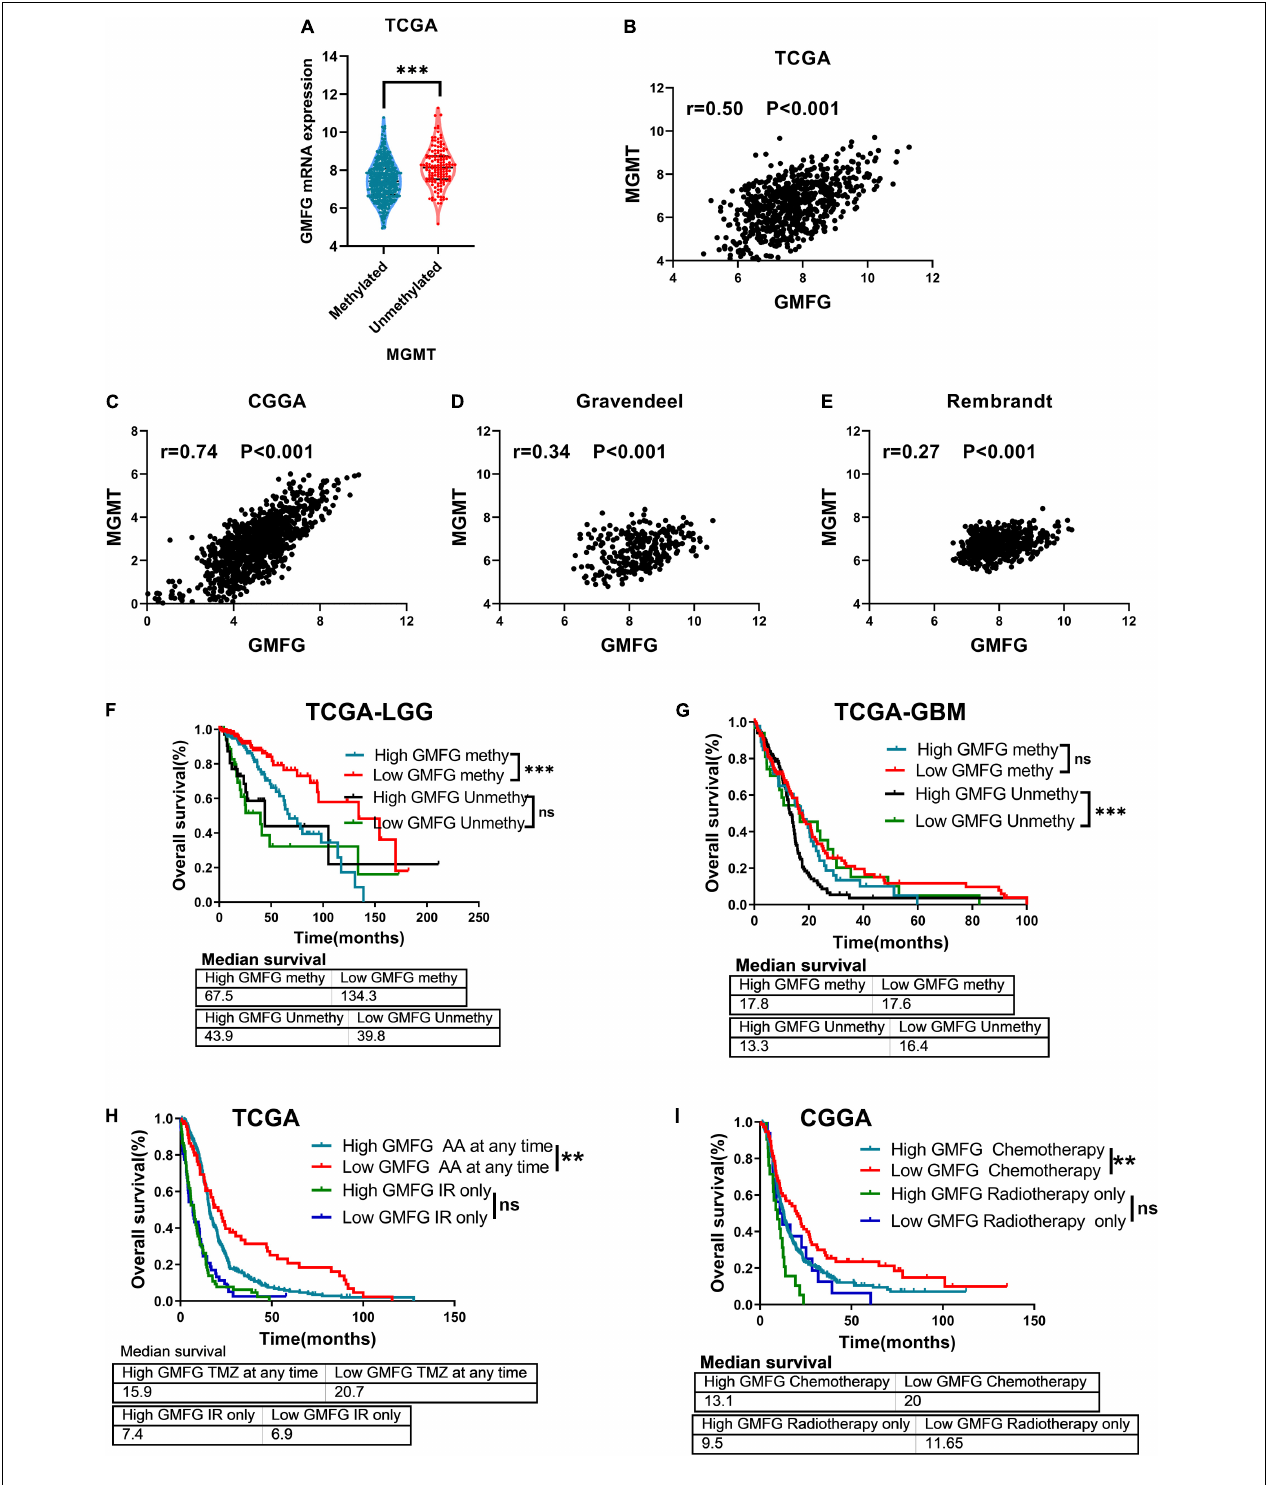
FIGURE 8 | Glia maturation factor- γ associated with TMZ response of gliomas. (A) Association between GMFG expression and MGMT promoter methylation status. ∗∗∗ P < 0.001. (B–E) Correlation between GMFG expression and MGMT expression in TCGA, CGGA, Gravendeel, and Rembrandt datasets based on Spearman correlation analysis. (F,G) Effect of GMFG on the prognosis of patients with LGG and GBM with different MGMT promoter methylation status. HR, hazard ratio. ∗∗∗ P < 0.001, ns, no significance. (H,I) Effect of GMFG on the prognosis of gliomas patients who received chemotherapy at any time or radiotherapy only. AA, alkylating agent; IR, ion radiotherapy. ** P < 0.01, ns, no significance.